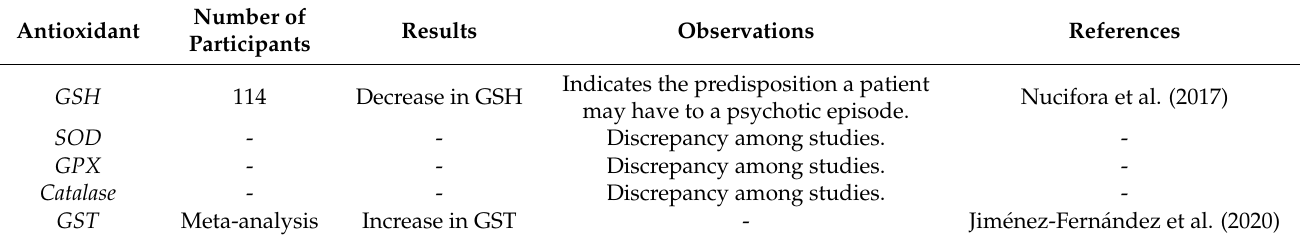
Table 4. Summary of antioxidant levels in